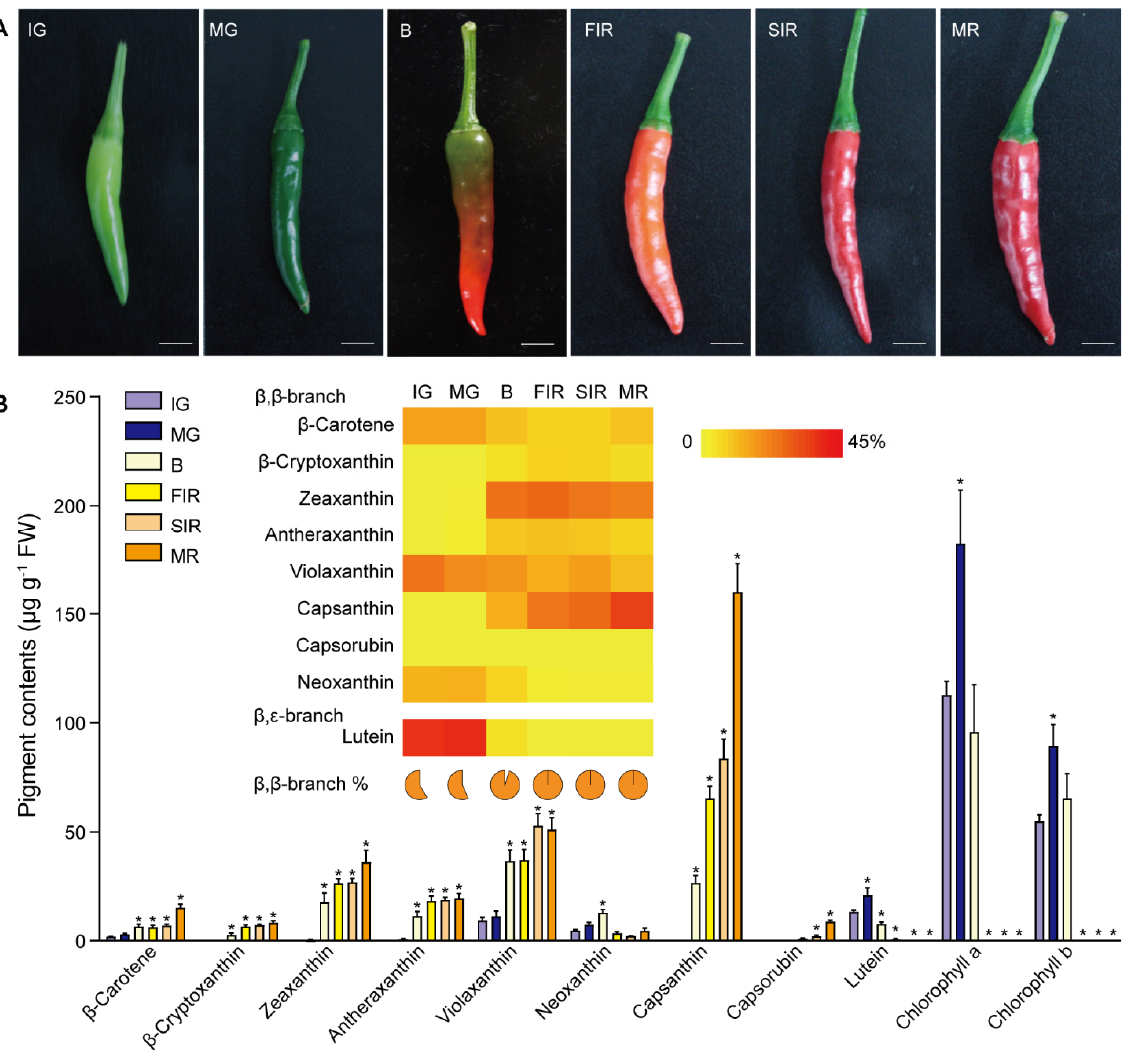
Figure 2. Variations of pigment contents in ripening chili pepper fruits. ( A ) Six stages of ripening chili pepper fruits. Abbreviations for each stage of samples: IG, immature green ( ca. 15 days post anthesis [DPA]); MG, mature green ( ca. 30 DPA); B, breaking ( ca . 35 DPA); FIR, first immature red ( ca . 38 DPA); SIR, second immature red ( ca. 43 DPA); and MR, mature red ( ca . 50 DPA). Scale bars = 1 cm. ( B ) Analyses of pigment contents in ripening chili pepper fruits. Carotenoids and chlorophylls were extracted from fruits at different ripening stages, separated by HPLC and then quantified. FW, fresh weight. Data are means ± SEM ( n = 3). * Significantly different from the pigment content in IG stage ( p < 0.05; one-way ANOVA and Tukey’s multiple comparisons test); the detailed